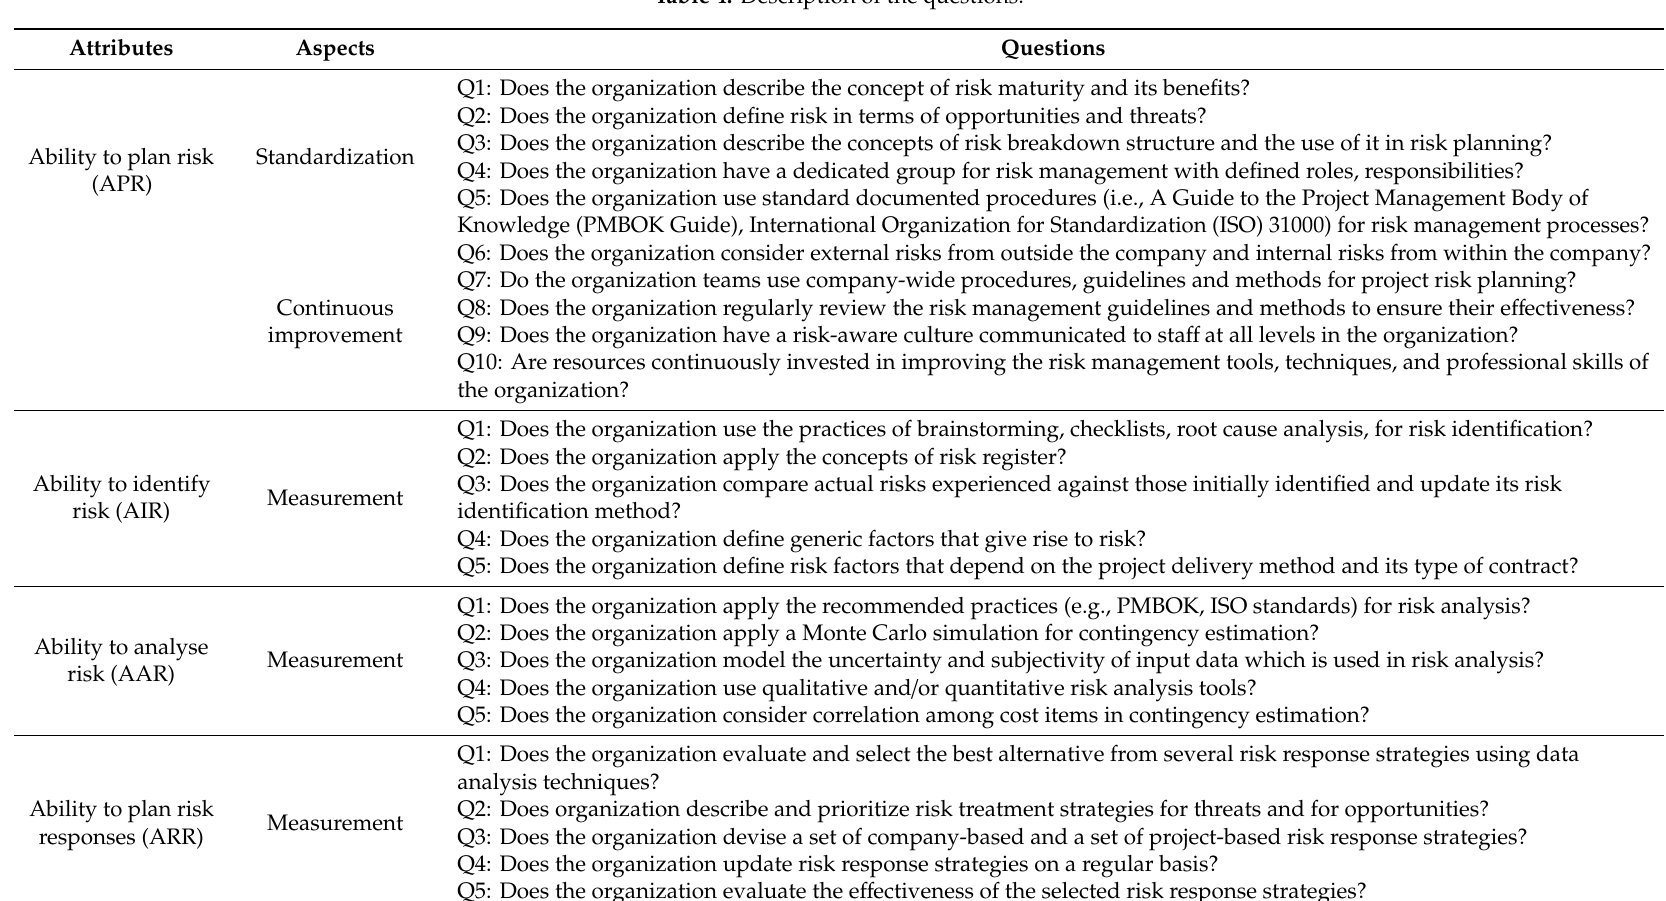
Table 4. Description of the